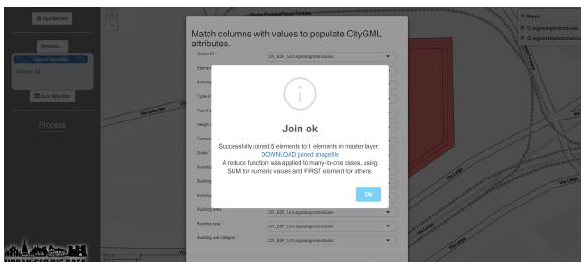
Figure 7. ZCityGML after choosing target and joined layers, user is guided through next steps.